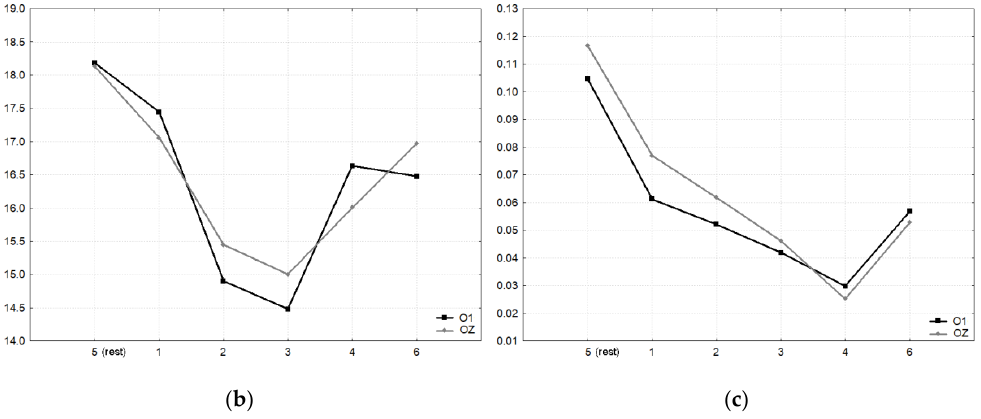
Figure 10. (a) VEPs generated by the standard stimulation (checkerboard) for all four subjects (columns, D, M, J, H) and the six rowing conditions (rows). The VEPs (referenced to Cz) measured at active electrode O1 and passive electrode Oz are superimposed. In addition, for subject H (right column), the VEP at O1 measured in the repeated test with the 14-channel cap with passive electrodes used in Study 3 is shown (dotted grey line). The six conditions were as follows: 1: Force low (F_low), stroke rate low (SR_low). 2: F_low, SR_high. 3: F_high, SR_low. 4: F_high, SR_high. 5: Rest (without rowing). 6: Arm pull only. Details are provided in the legend of Figure 9. The numbers at the bottom of the graphs present the correlation coefficients between the respective rowing condition and rest (after correcting latency delays up to 39 ms (mean 14.6 ms) between the two ERP waveforms, which sometimes occurred due to timing inaccuracies between the different hardware systems). ( b ) VEP peak differences (max–min) for conditions 1–6 (mean of all four subjects). The differences, which represent higher peak amplitudes, were largest in the resting condition (condition 5); however, the differences were not significant. ( c ) Signal-to-noise ratio (SNR) values for conditions 1–6 (mean of all four subjects). SNR decreased with increasing movement intensity. The rest condition differed significantly from all rowing conditions, as well as rowing conditions 1 and 4. No significant difference between both electrodes (O1 active, Oz passive) was found. For the peak differences, no statistical difference was found. For the SNR, the test of the main effect for each condition resulted in F (5,38) = 10.73, p < 0.0001; for the electrode effect, the test was not significant (F (1,38) = 0.60, p = 0.4415). After Bonferroni adjustment, the SNR differed significantly between condition five (rest) and all rowing conditions (p values between 0.032 and < 0.0001). Rowing condition four (highest power) differed additionally from condition one (p = 0.0236).